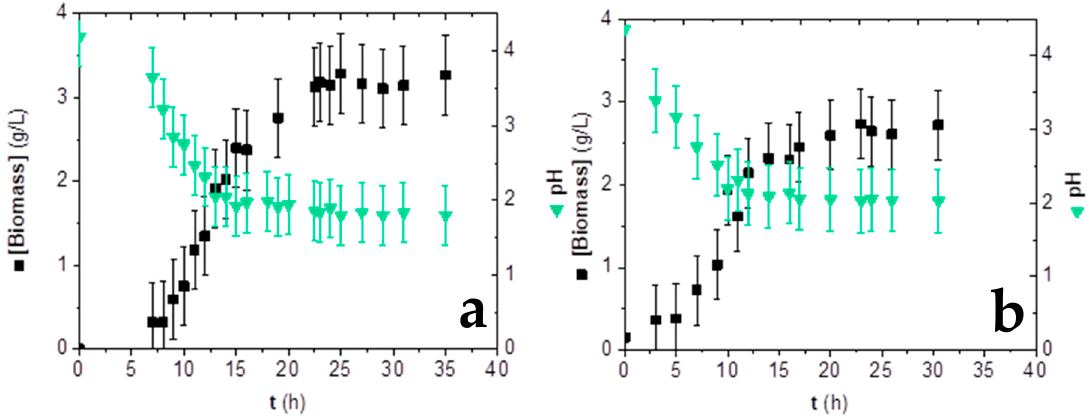
Figure 4. Rhizopus arrhizus NRRL 1526 first ( a ) and second ( b ) inoculum stages growth at 34 °C and free pH evolution in medium B.